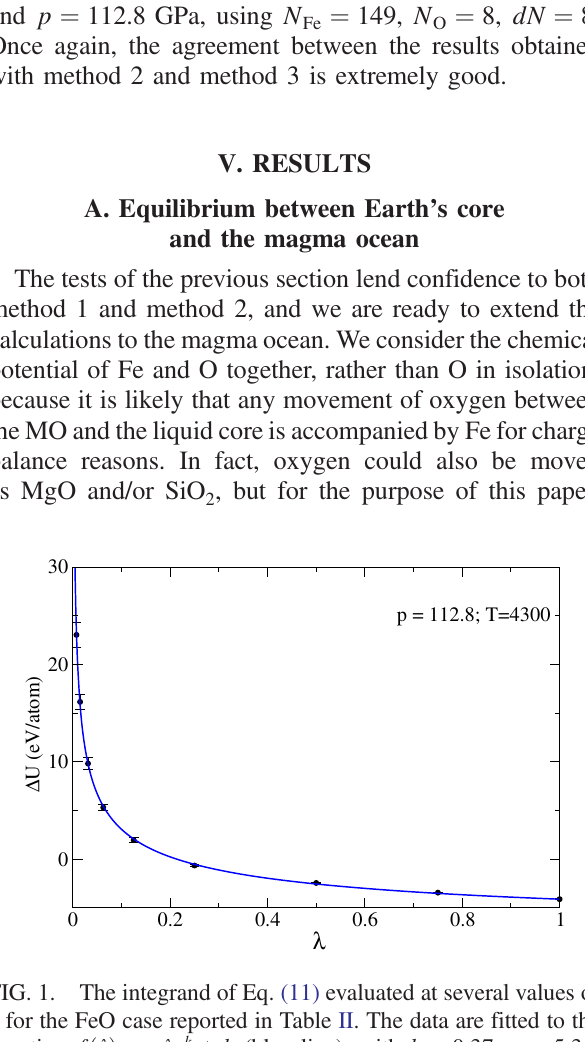
TABLE III. Excess chemical potential of FeO, ˜ μ k at T ¼ 5500 K calculated using method 1 [method 2]. For comparison, we also report the value in solid Mg 63 FeO 64 .